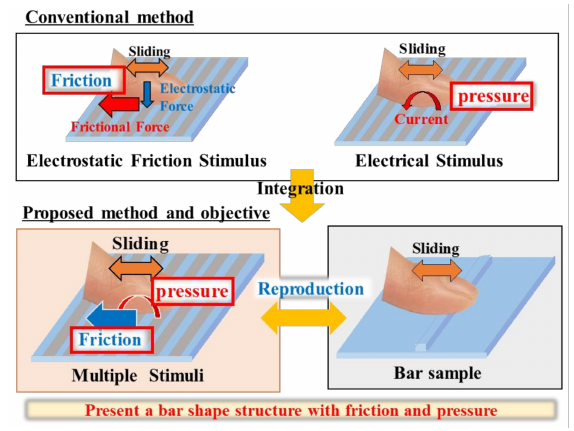
Figure 1. The concept and objective of the